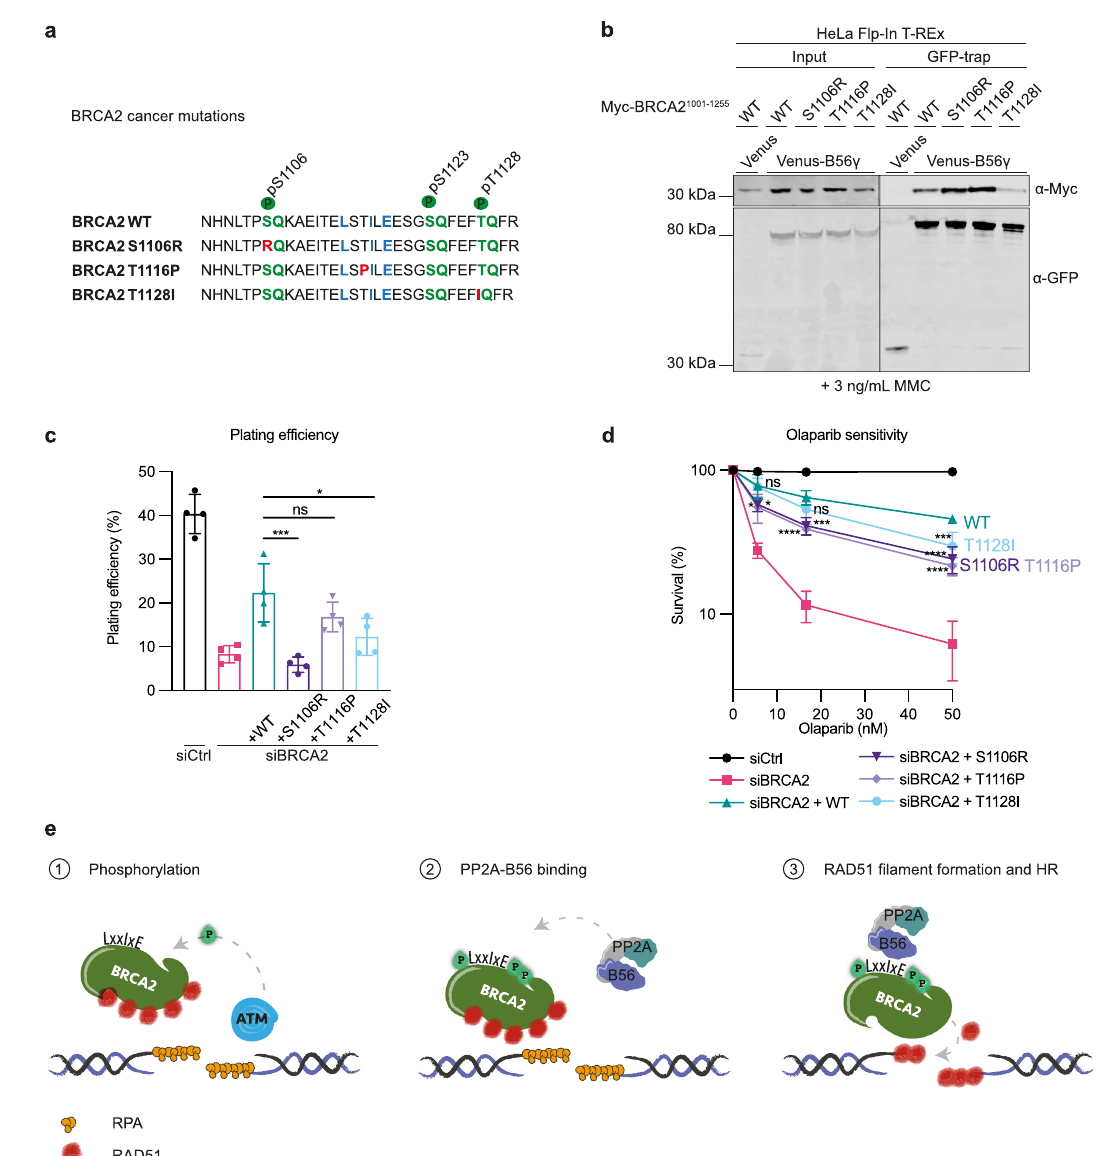
Fig. 4 BRCA2 cancer mutations deregulate PP2A-B56 binding and sensitize cells to PARP inhibition. a Schematic of the B56 binding region of human BRCA2 with the introduced cancer-associated mutations indicated. b Western blot of the co-immunoprecipitation of Myc-BRCA2 1001 – 1255 WT, S1106R, T1116P, or T1128I with Venus-B56 γ from HeLa Flp-In T-REx cells in presence of 3 ng/mL MMC. Representative of three independent experiments. c, d U2OS Flp-In T-REx parental cells or stably expressing siRNA-resistant WT, S1106R, T1116P, or T1128I Venus-MBP-BRCA2 cDNAs were transfected with Ctrl or BRCA2 siRNA. Colony formation assays were performed to determine plating ef fi ciency ( c ) and Olaparib sensitivity ( d ). Data are presented as means ± standard deviations for four independent experiments. One-way ANOVA analyses with Dunnett ’ s multiple comparison tests were performed to compare each condition to siBRCA2 + WT. * p < 0.5, *** p < 0.001, **** p < 0.0001, ns nonsigni fi cant. e Model. In the presence of DNA damage such as DSBs, ATM and ATR kinases phosphorylate BRCA2 on S1106, S1123, and T1128. This stimulates the binding of PP2A-B56 through a conserved LxxIxE motif, thus recruiting PP2A-B56 to the broken DNA. The phosphorylation-regulated binding of PP2A-B56 to BRCA2 is required for RAD51 fi lament formation and DNA repair by